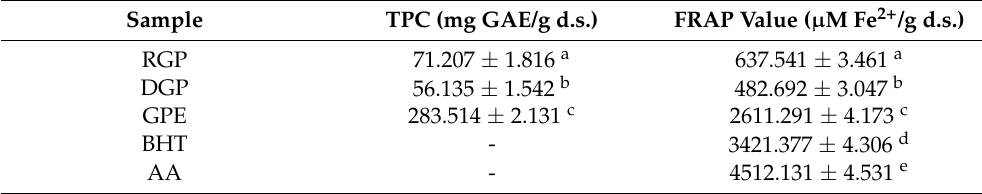
Table 1. FRAP value and total phenolic content (TPC) of the samples tested.